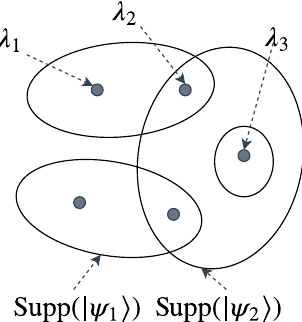
FIG. 4. Each circle corresponds to a support of a quantum state; there are thus j S j circles. Each dot corresponds to a hidden variable. We denote the number of dots as V , and the number of circles that a dot belongs to is, at most, m . Imagine that we eliminate a dot and its associated circles each time. After V steps, all of the circles are eliminated. Since each time we can eliminate at most m circles, we have Vm ≥ j S